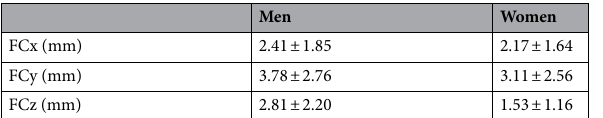
Table 4. The differences between the measured and calculated values. All values are expressed as mean ± standard deviation.